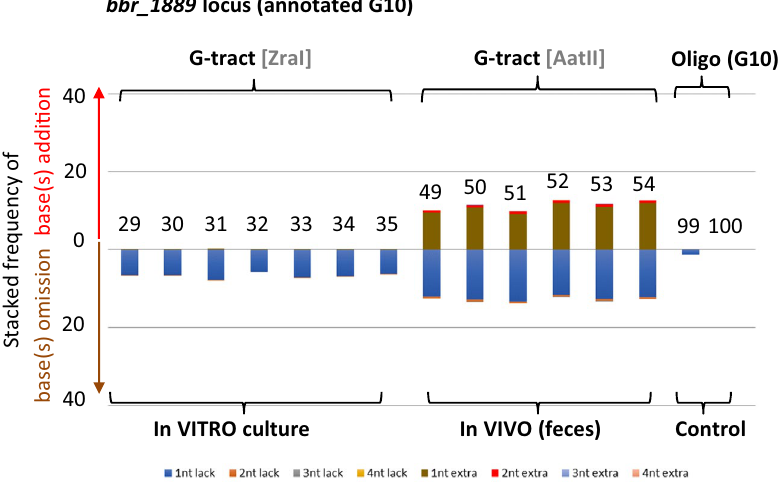
Figure 6. Replication slippage analysis by Maximum Depth Sequencing (MDS). The stacked frequency of inDel at G/C tract of bbr_0113 locus ( A ) and bbr_1889 locus ( B ) is indicated for each specific number of base(s) addition or omission, with the frequency of the annotated nt length being omitted. The MDS analysis reveals the distribution of InDel derived from only one of the chromosomal DNA strands specifying the G-tract (DNA coding strand) or the C-tract (non-coding DNA strand). The identity of the chromosomal DNA strand with the restriction site used for the MDS is indicated at the top. The general cultivation condition of UCC2003 for each sample (numbering above each stacked frequency bar) is shown at the bottom, with the specific cultivation conditions also indicated in SI Table S1. The condition ‘control’ refers to a control experiment involving chemically synthesized oligonucleotides specifying the region of interest encompassing either the forward or reverse chromosomal DNA strand of bbr_0113 or bbr_1889